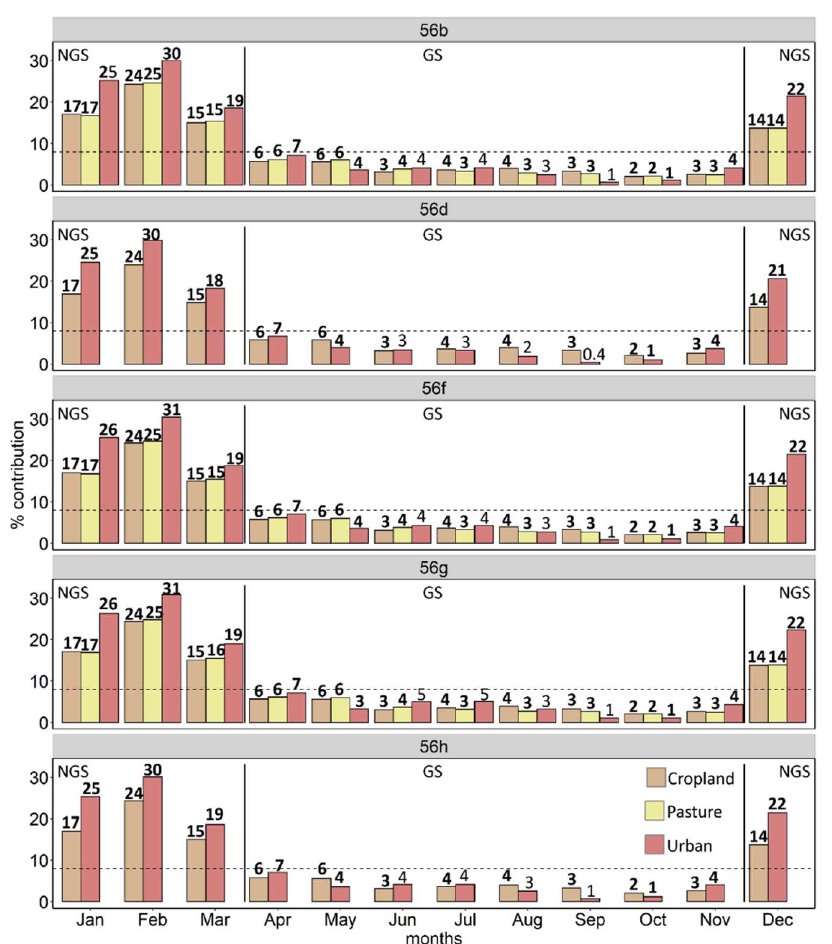
Figure 6. Percent contribution of albedo-induced global warming impact (GWI Δα ) to cooling (values in bold) or warming effects by season and month periods for major cover types in the five Level IV ecoregions. The horizontal dashed line represents the average contribution ~8% (i.e., 1/12 of the annual total), and the solid vertical lines separate the non-growing season (NGS) from the growing season (GS) months. Values of March were missing and gap-filled as the mean GWI Δα of February and April.